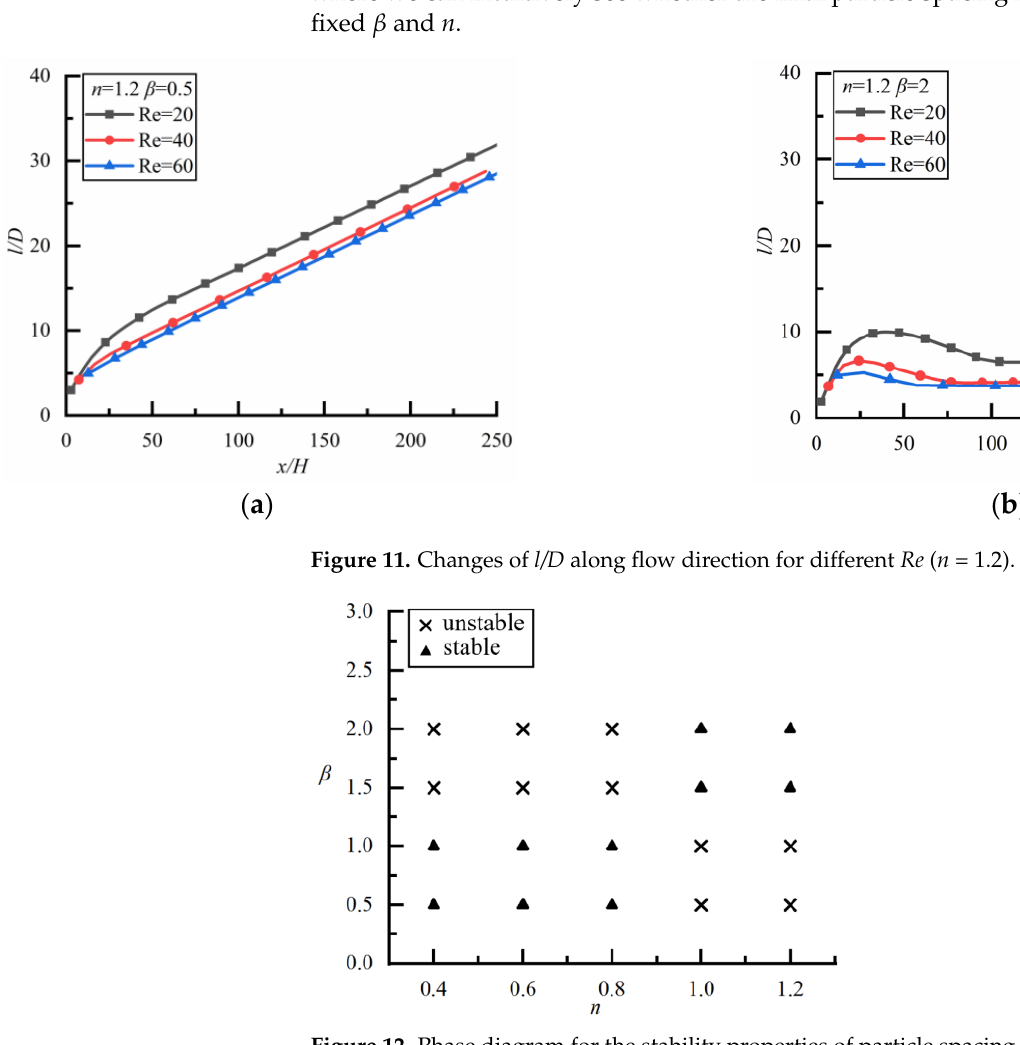
Figure 12. Phase diagram for the stability properties of particle spacing under different β and n .